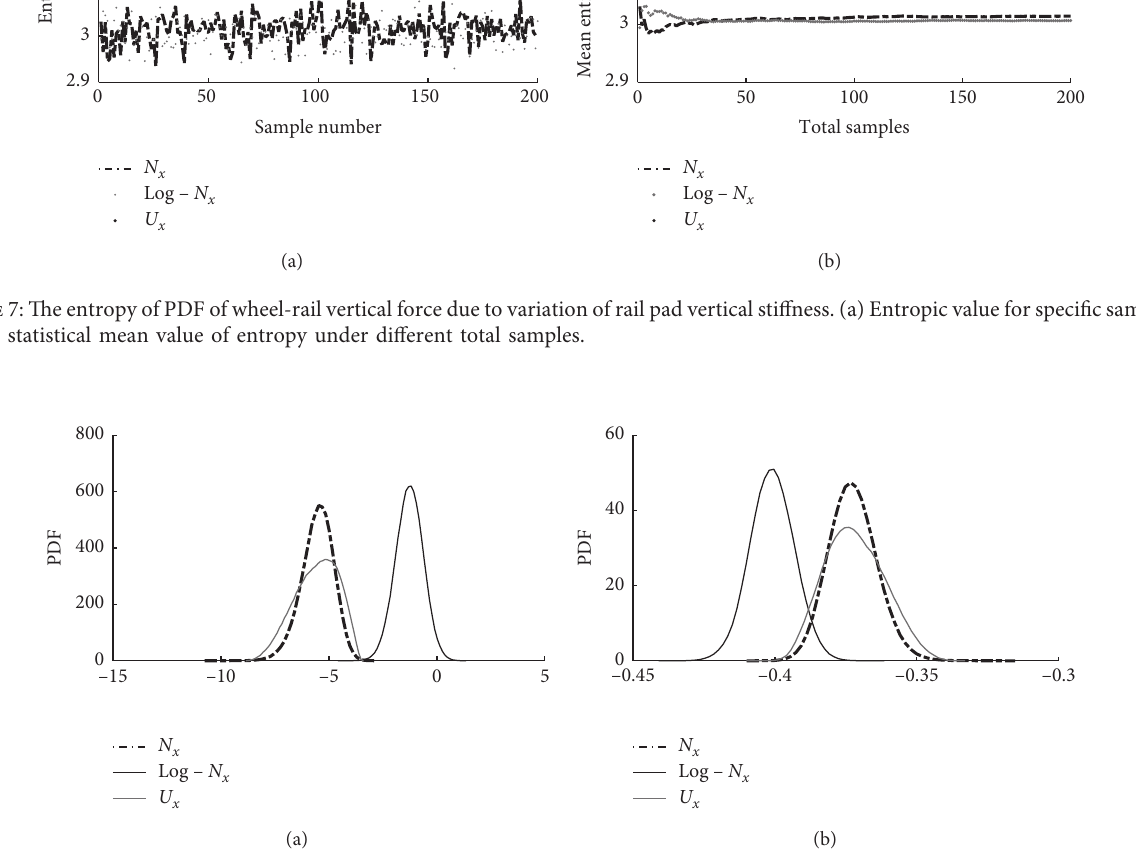
Figure 8: PDF of dynamic indices due to longitudinal inhomogeneity of rail pad lateral stiffness. (a) Rail lateral displacement; (b) wheel-rail lateral displacement.